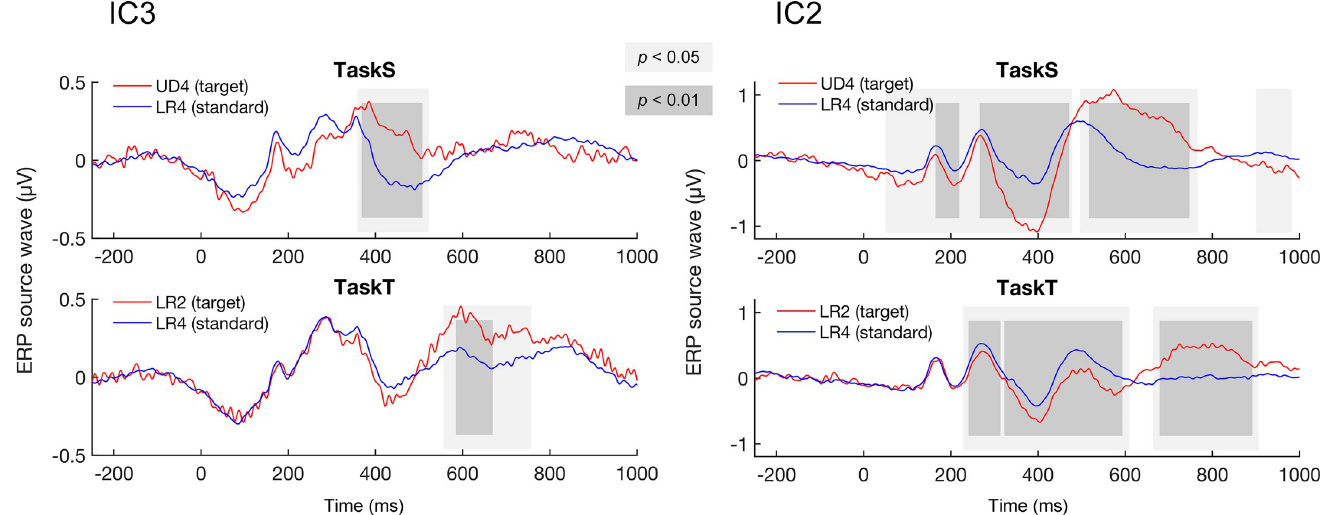
Fig 6. Responses representing higher-level processes. Significant differences occurred between IC3 to standard and target stimuli in both TaskS and TaskT. In addition, significant differences occurred between IC2 to standard and target stimuli in both TaskS and TaskT. Consistent with behavioral reaction time and IC1 results, response differences started earlier in TaskS than in TaskT for both IC3 and